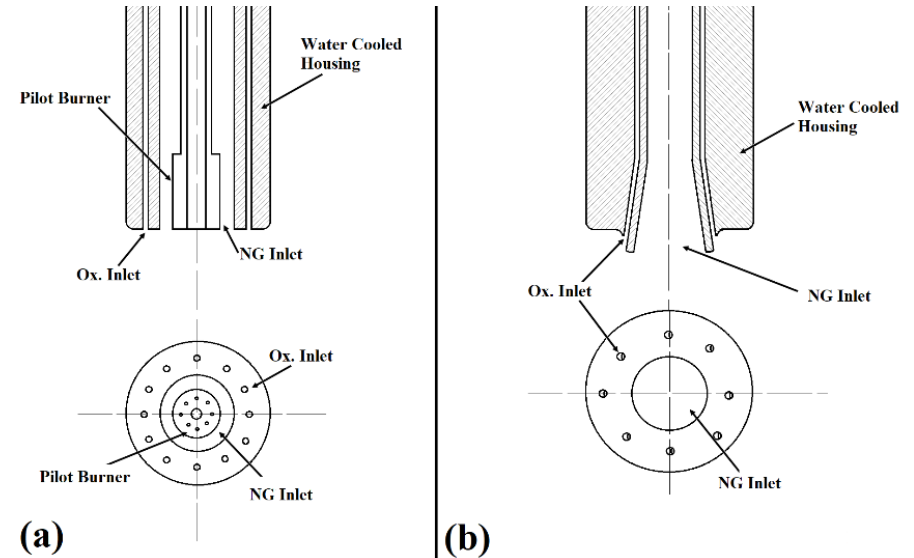
Figure 5. Schematic diagrams for ( a ) preheat burner and ( b ) main burner. NG stands for natural gas and Ox for oxygen.